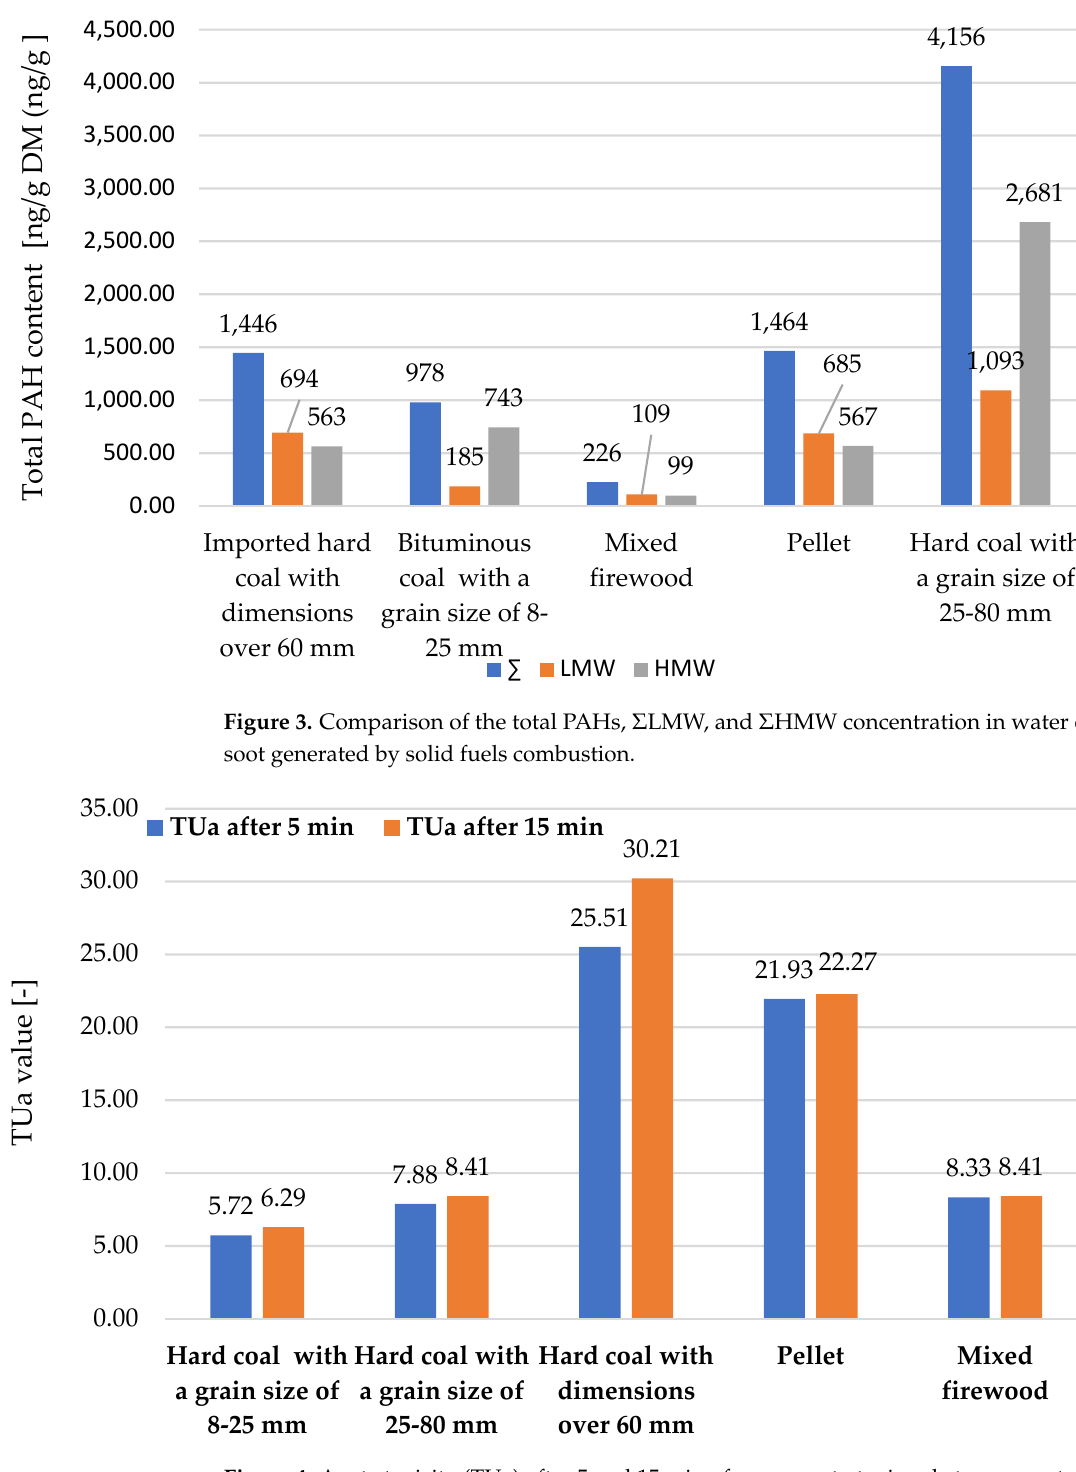
Figure 4. Acute toxicity (TUa) after 5 and 15 min of exposure to toxic substances contained in water extracts from samples of soot from the combustion of solid